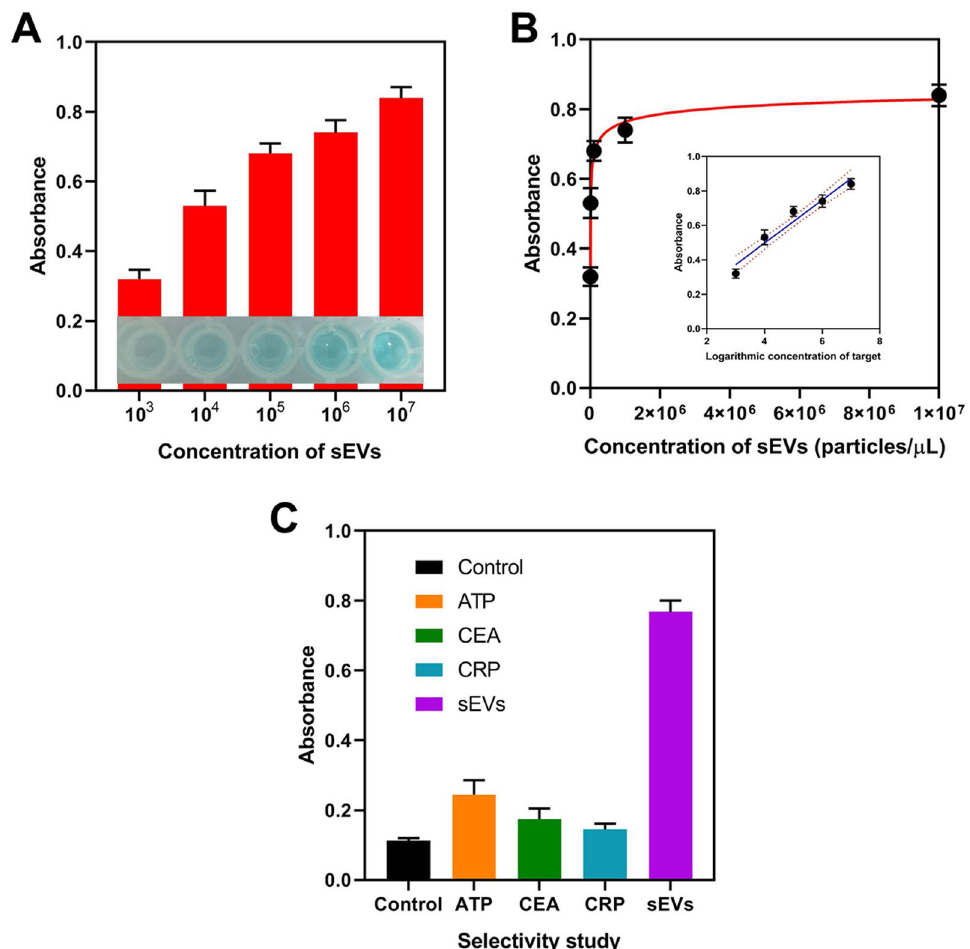
Fig. 5 Detection performance of the established approach. A Absorbance of the established approach for different concentrations of sEVs detection. B Correlation between the absorbance and the concentration of sEVs. C Absorbance of the approach when detecting interferents